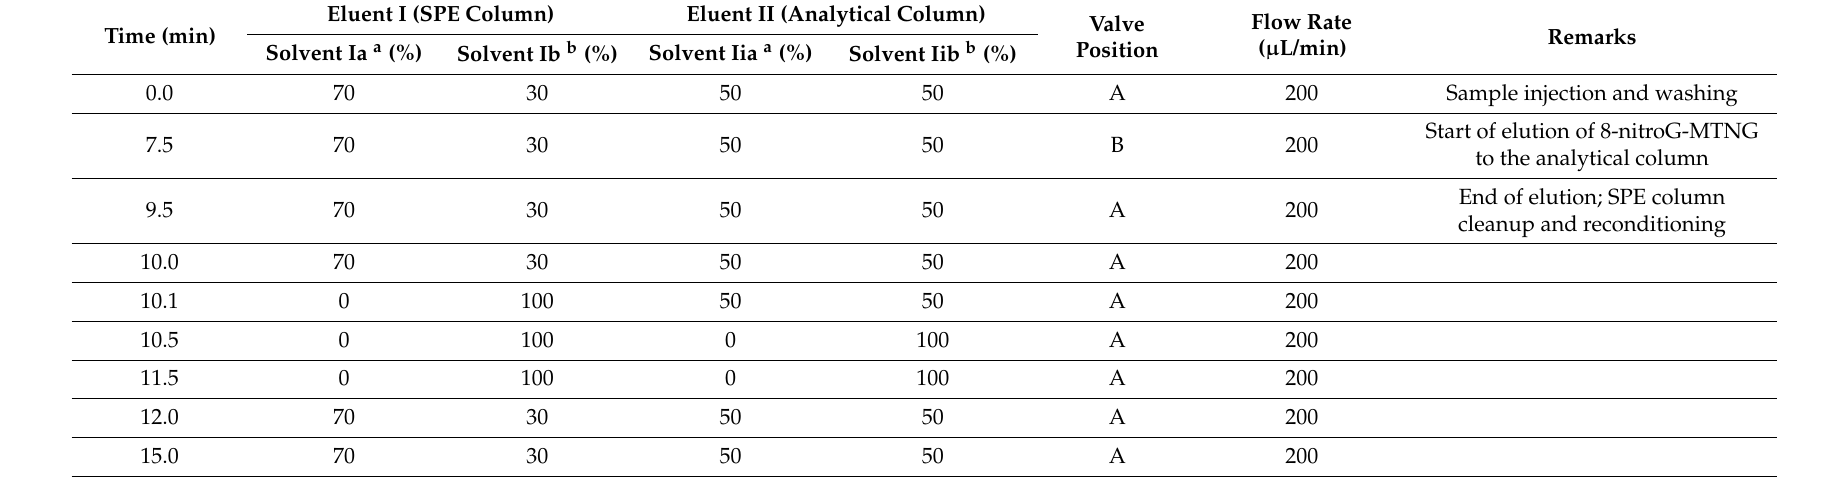
Table 2. Timetable for the column-switching